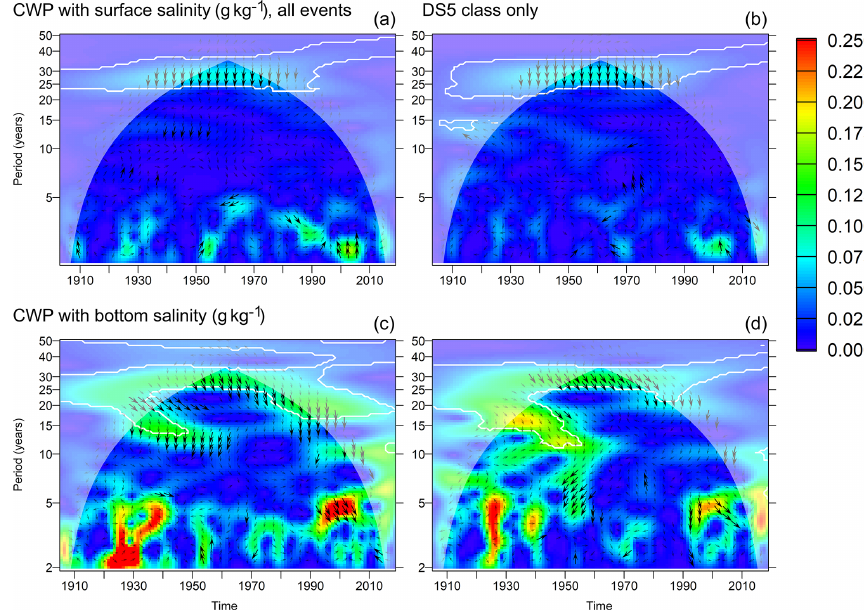
Figure 11. Common wavelet power between observed surface and bottom salinity at station BY15 (Eastern Gotland Basin) and normalized annual import of salt by inflow events. (a, c) All inflow events identified in Mohrholz (2018). (b, d) Only DS5 class events. White contours indicate that the WA or CWP is significant at the 95% confidence level with respect to a random shuffling of the annual means of the salt import. Arrows indicate relative phase: → : in phase; ↓ : salt import leading salinity by 90 ◦ . Thick arrows indicate phase stability (wavelet coherence > 0.95). The region where arrows are not drawn indicates the cone of influence for the common wavelet power; the white shading indicates the cone of influence for the wavelet